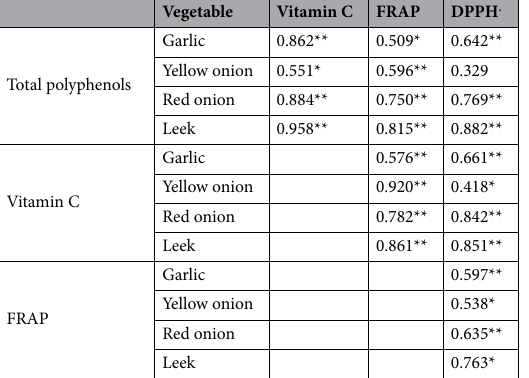
Table 3. Pearson correlation coefficients between the content of DPPH ⋅ and that of total polyphenols, vitamin C, and FRAP. *Correlation significant at p ≤ 0.01 (one-way analysis). **Correlation significant at p ≤ 0.001 (one- way